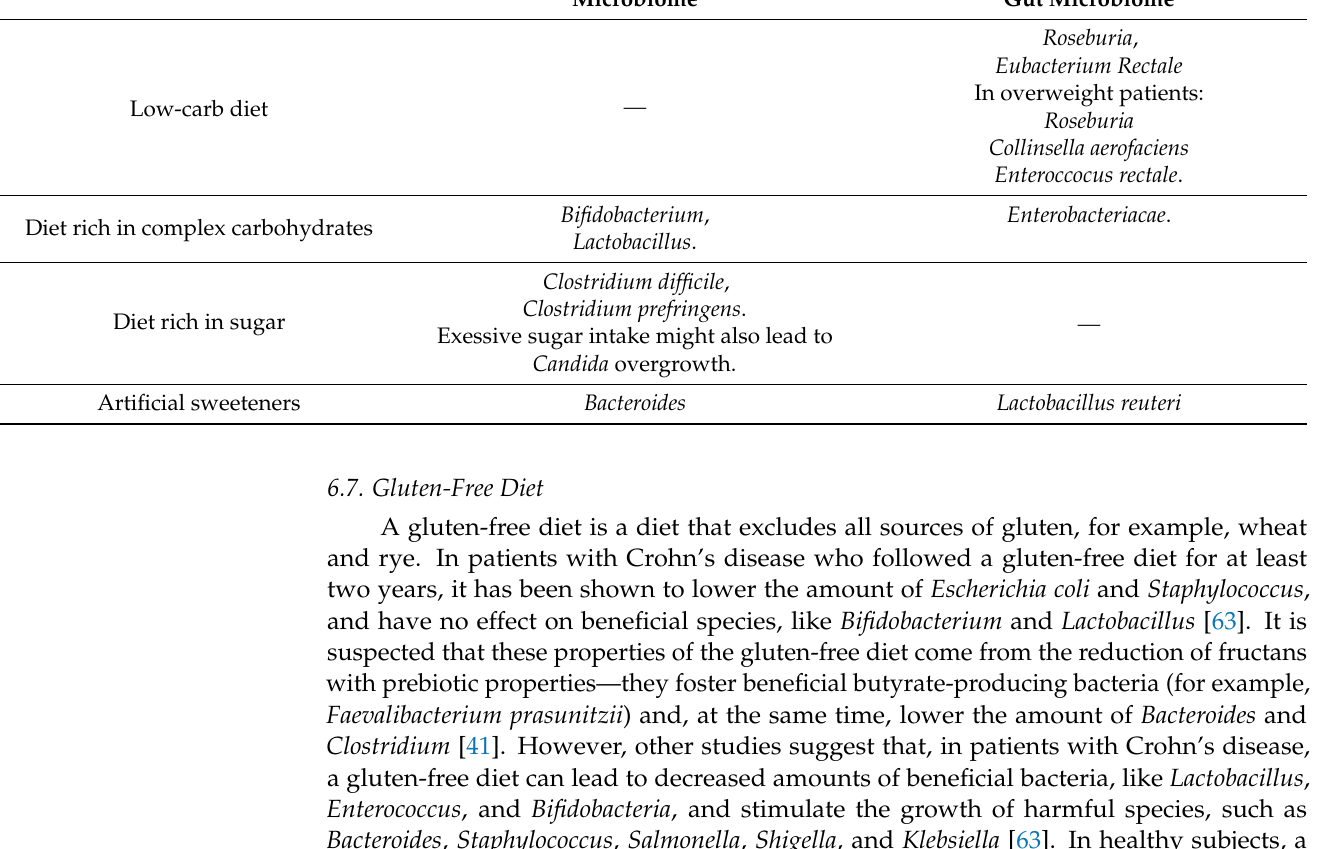
Bacteria Predominant in the Gut Bacteria with Reduced Numbers in the Microbiome Gut Microbiome Roseburia , Eubacterium Rectale In overweight patients: Roseburia Collinsella aerofaciens Enteroccocus rectale . Bifidobacterium , Enterobacteriacae .